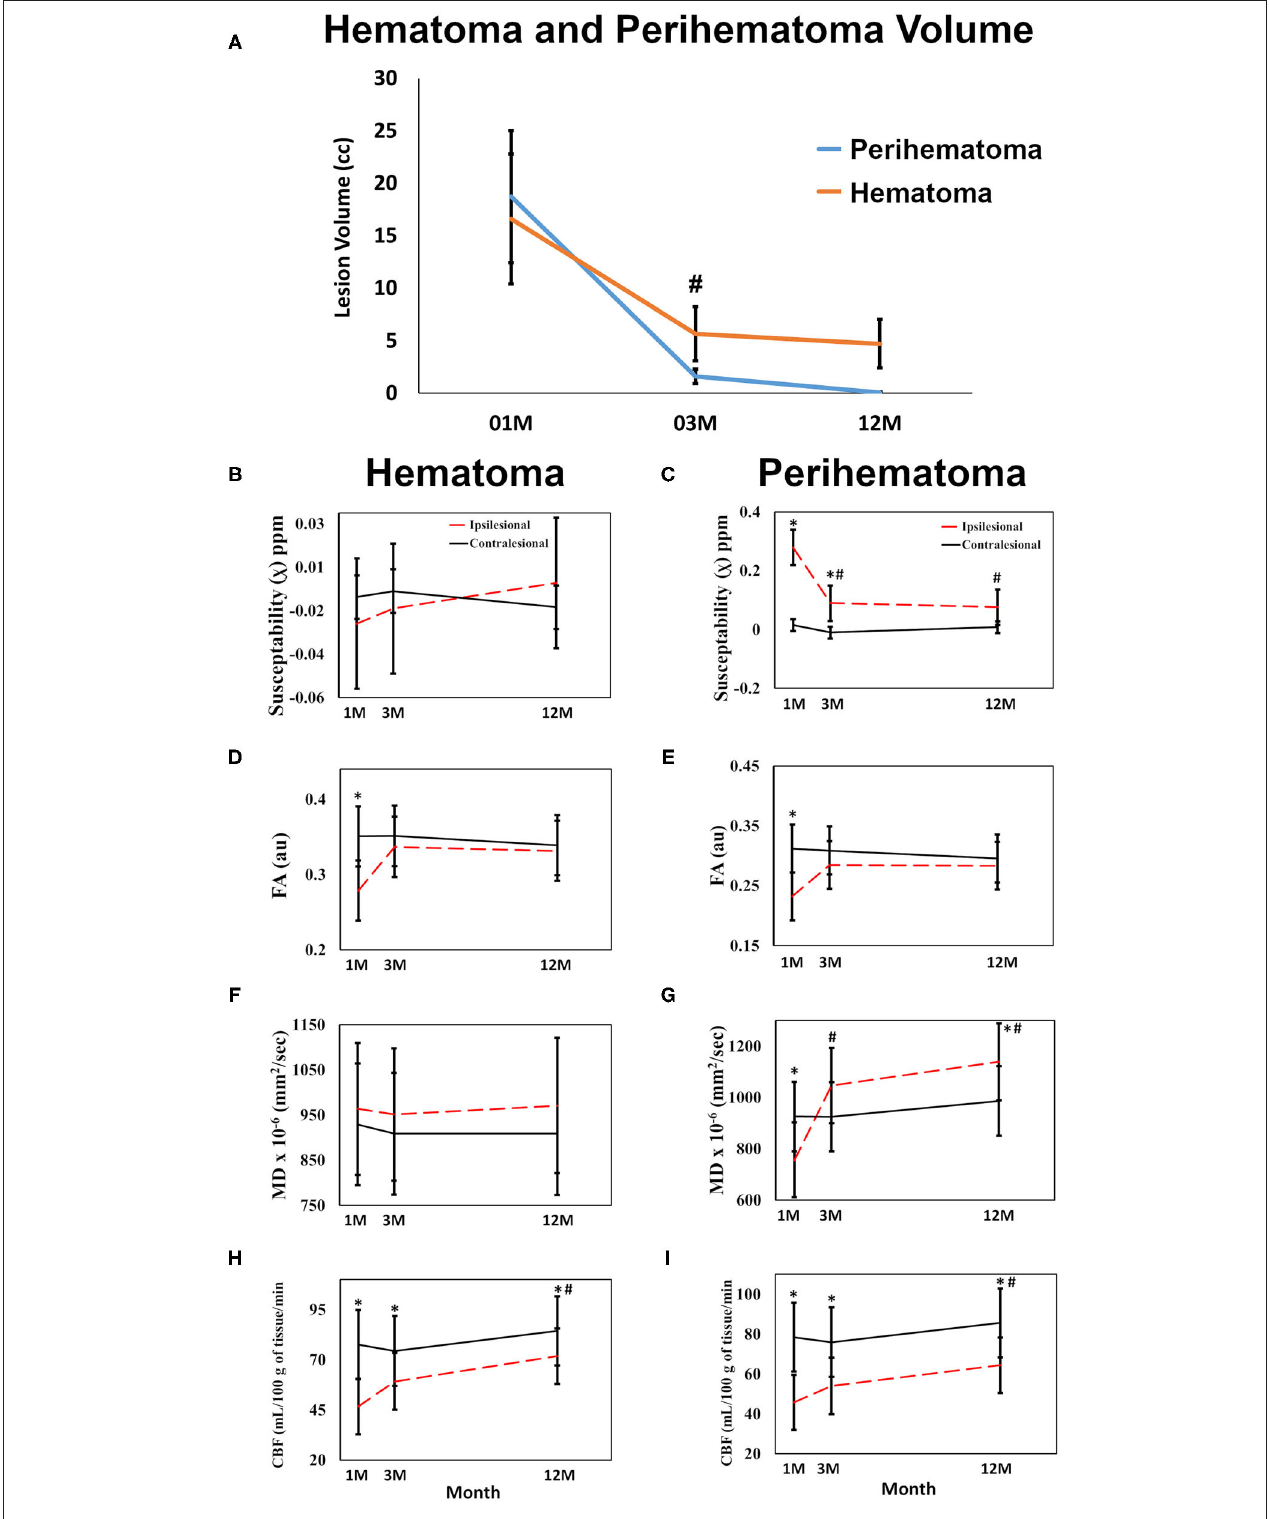
FIGURE 4 | Quantitative changes in imaging matrices are shown over time in the hematomal and perihematomal ROIs compared to the matching contralesional one. (A) Significant reduction in both the perihematoma and hematoma volume between 1 and 3M with no significant reduction thereafter. Plots (B,C) changes in susceptibilities; (D,E) FA; (F,G) MD changes over time in the hematoma and perihematomal ROIs compared to the contralesional side. (H,I) temporal changes CBF in the hematoma and perihematoma ROIs as compared to the contralesional side. * p < 0.05 as compared with the contralesional tissues, # p < 0.05 ipsilesional changes over time as compared with the 1M, error bar are STD